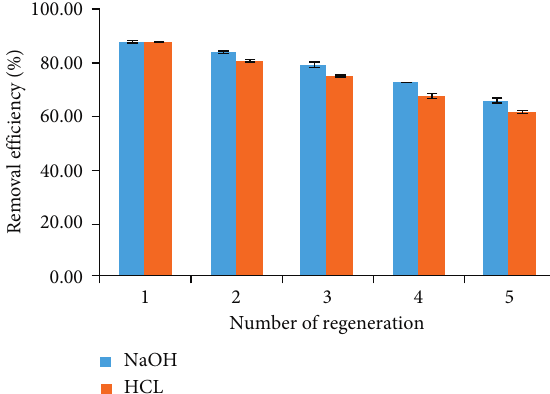
Figure 12: The removal of TC using NCPML after five regenerations. Error bars show standard deviation of three replicates.